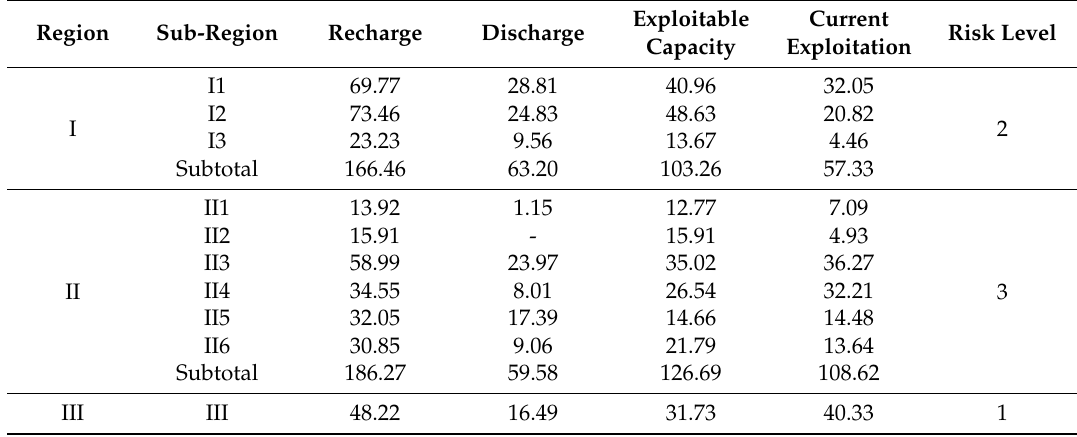
Table 2. Water balance of groundwater in Jinan karstic spring basin.